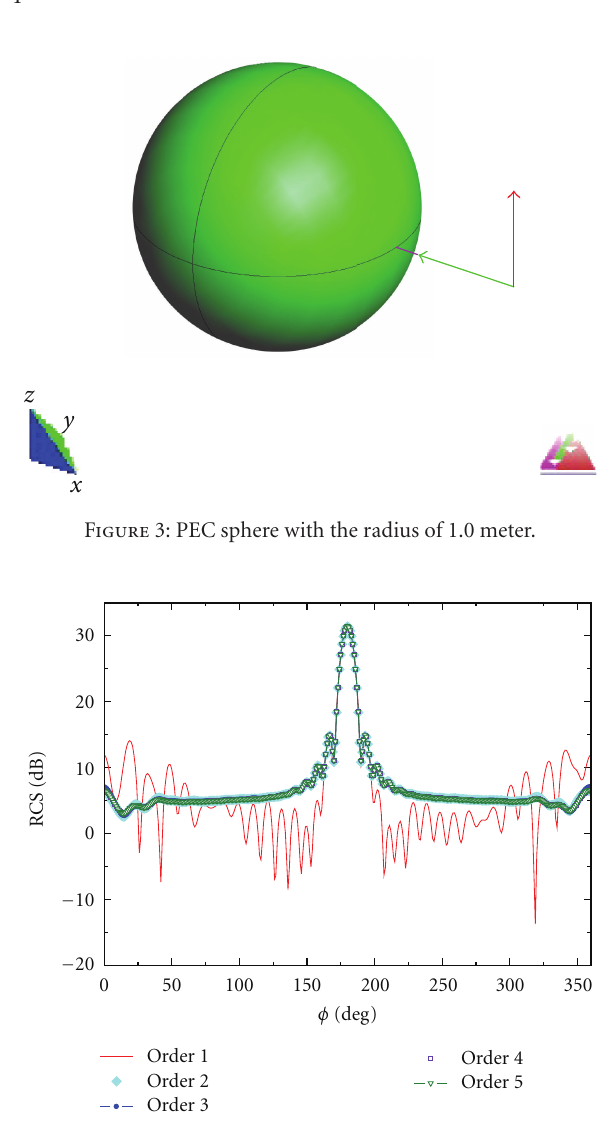
equal to 2.3 TB. No hard disk storage is available for computation. InfiniBand is used for the network interconnection.